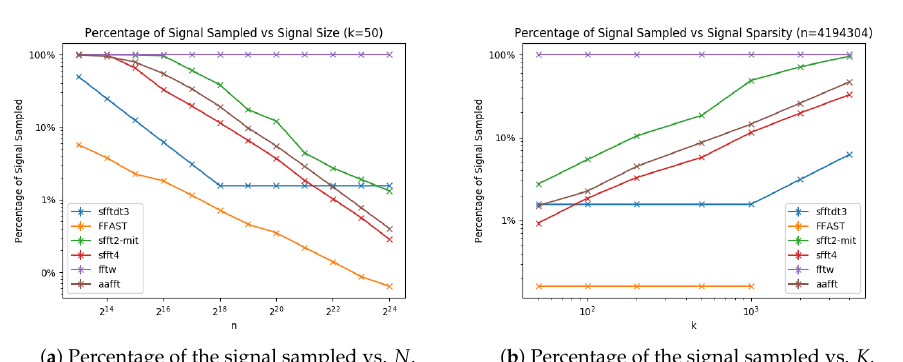
Figure 11. Percentage of the signal sampled of two typical algorithms using the aliasing filter and four other algorithms, including the sFFT-DT3.0, R-FFAST, sFFT2.0, sFFT4.0, fftw, and AAFFT0.9 algorithms in the general sparse case.